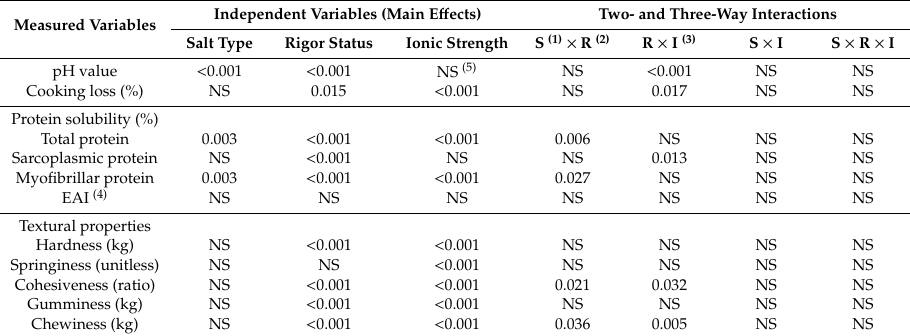
Table 2. Significance of p -value of main e ff ects and their interactions on measured variables of salted chicken